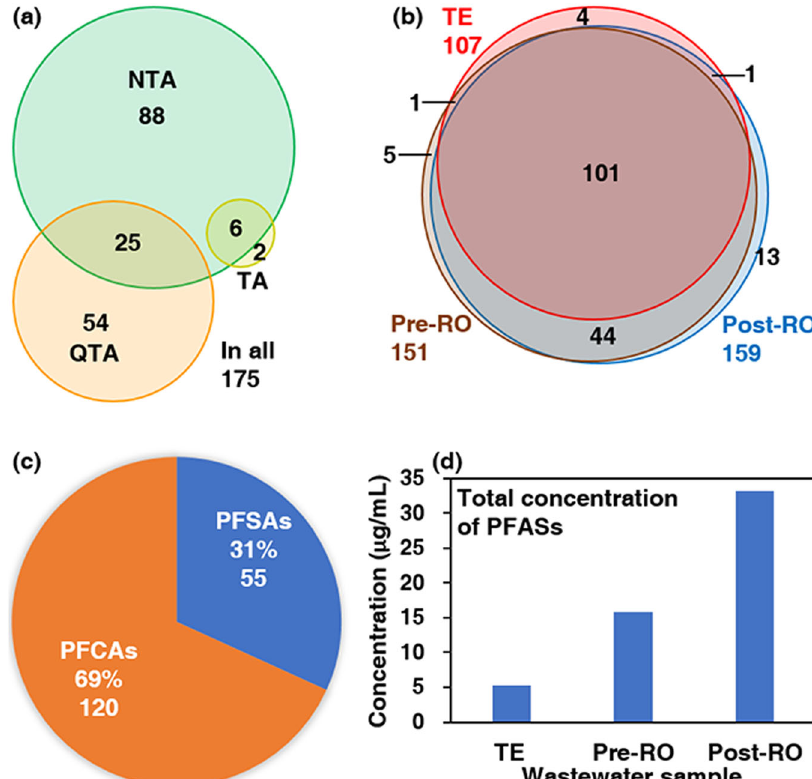
Fig. 1 Outline of the PFASs identi fi ed in the wastewater. a Formula numbers found by nontarget analysis (NTA), quasi-target analysis (QTA) and target analysis (TA); 88, 54 and 2 formulae were exclusively found by NTA, QTA and TA, respectively; 25 formulae were identi fi ed by both NTA and QTA; 6 formulae were found by both NTA and TA. b Formula numbers found in the three samples, i.e., total ef fl uent (TE), before reverse osmosis treatment (Pre-RO), and after reverse osmosis treatment (Post-RO); 101 formulae were found in all the wastewater samples; 44 formulae were found in both Pre-RO and Post-RO; 1 formula was found in both TE and Pre-RO; 1 formula was found in both TE and Post-RO; 4, 5 and 13 formulae were exclusively found in TE, Pre-RO and Post-RO, respectively. c Formula numbers and proportions of the identi fi ed